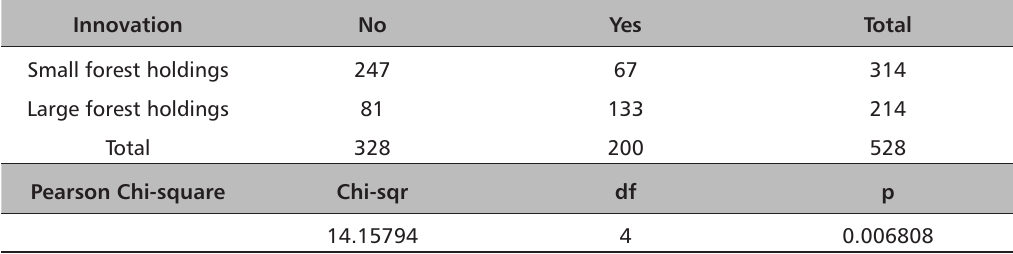
* presented data represent results from joined dataset (2002 and 2010 survey)